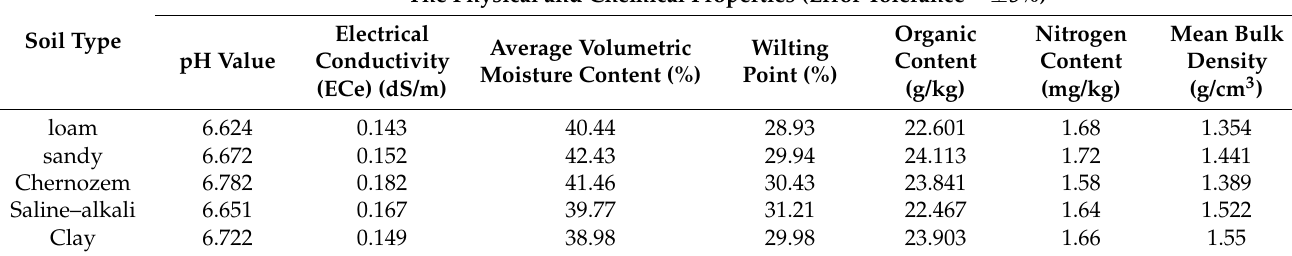
Table 2. The physical properties of tested soil